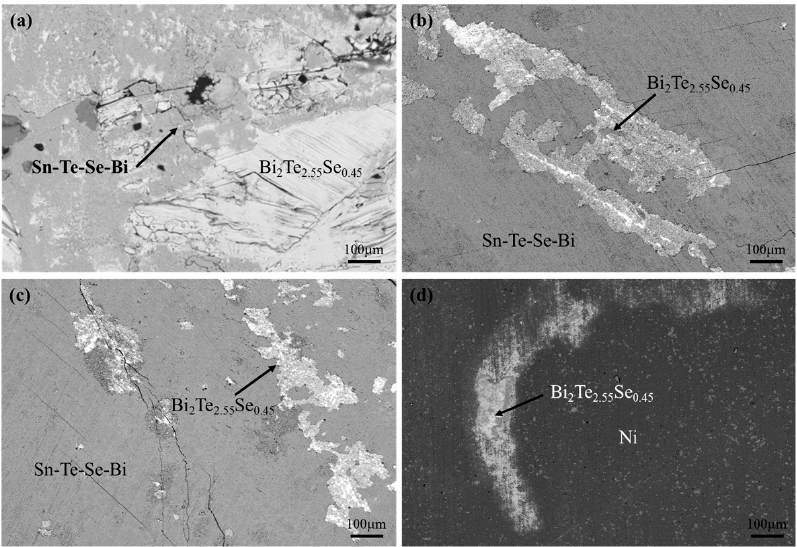
Figure 10. Fractured surfaces of shear ‐ tested Bi 2 Te 2.55 Se 0.45 /Cu joints, diffusion ‐ soldered at various temperatures for 60 min using Sn interlayers: ( a ) 250 °C, ( b ) 275 °C, ( c ) 300 °C, ( d ) 325 °C.